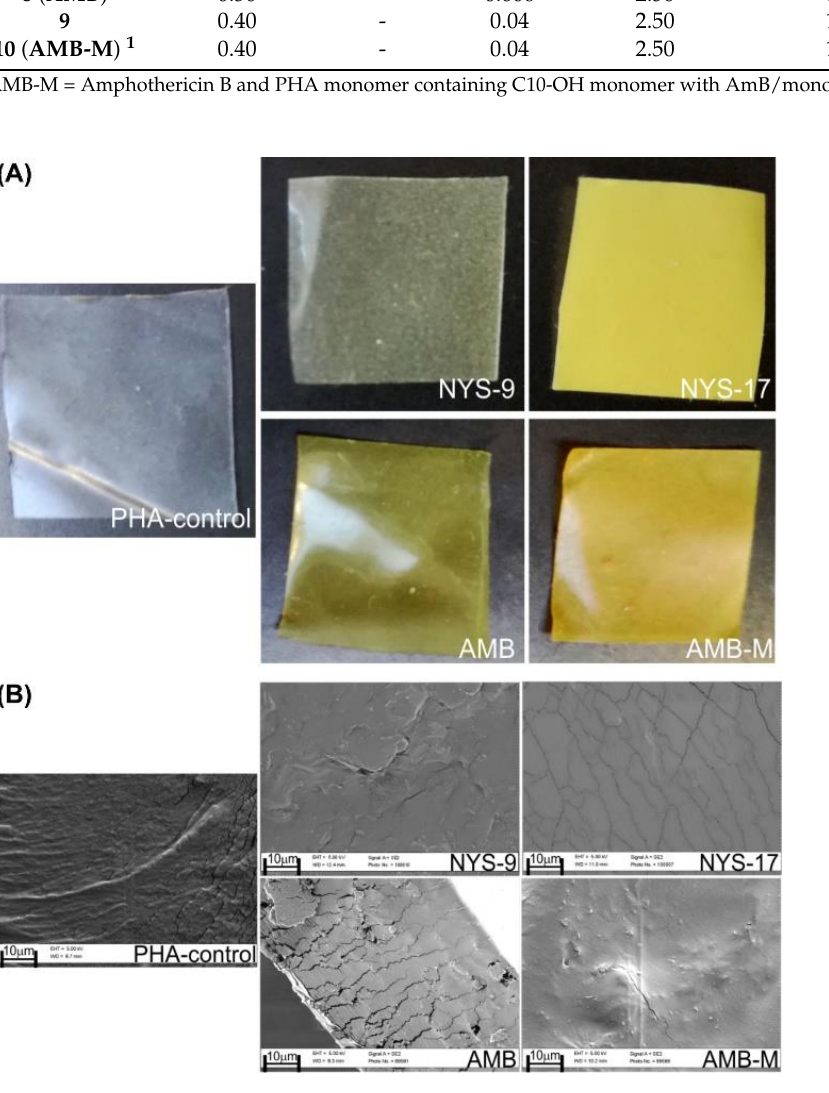
Figure 1. ( A ) Photographs and ( B ) SEM micrographs of the mcl-PHA films (neat and loaded with NYS-nystatin and AMB-amphotericin B). AMB-M sample contains 0.4 % wt C10-OH monomer.